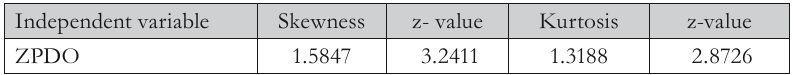
Tab. 5 – Skewness, kurtosis and z-value of independent variable in the model of problems with